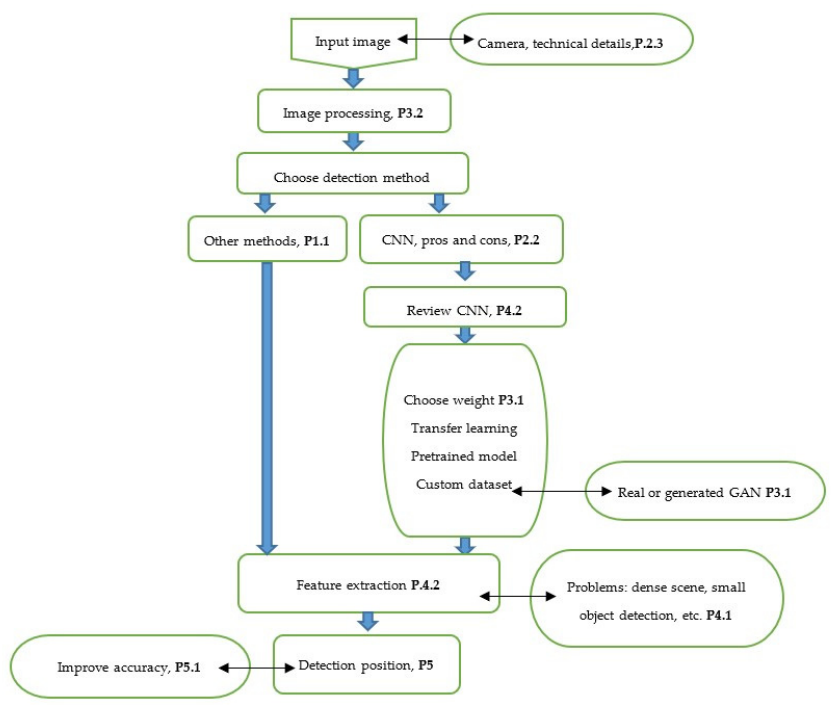
Figure A1. Block diagram of the various stages of the weed detection process. Numbers refer to related subsections in the article.